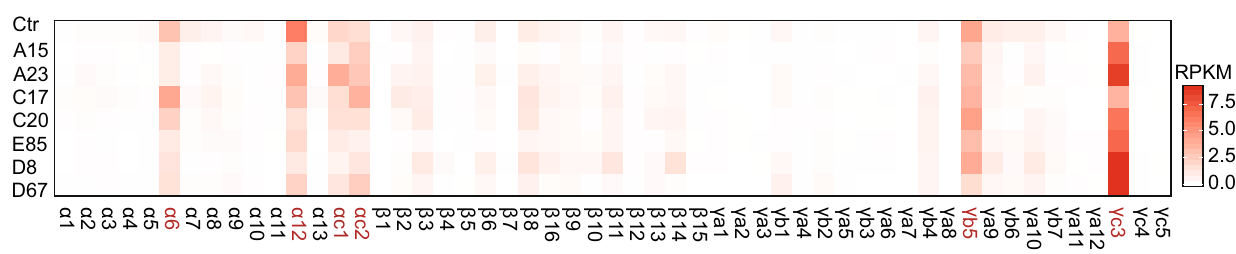
b Figure 1. Genetic dissection of the Pcdh α HS5-1 enhancer architecture by CRISPR DNA-fragment editing . (A) Schemat- ics of the three human Pcdh gene clusters (hPcdh α , β , and γ ) and the inversion experiments mediated by CRISPR DNA- fragment editing. The orientation of CBS arrays is indicated by horizontal arrowheads. The DNase I hypersensitive sites within super-enhancers are indicated by vertical arrows. The HS5-1 enhancer and its various CRISPR inversions are highlighted below. Two tandem CBSs in a reverse orientation ( HS5-1a and HS5-1b ) at the editing sites are also highlighted. SLC25A2 and TAF7 are two non-Pcdh genes. CBS, CTCF-binding site; HS, hypersensitive site; SE, super-enhancer; TF, transcription factor. (B) Shown are 4C chromatin-interaction pro fi les in the wild-type control (Ctr) and CRISPR cell lines with inversion of the CBS HS5-1b only (Inv I) or the HS5-1b combined with the middle region (Inv II) using the HS5-1 enhancer as a viewpoint. The signi fi cance of interactions ( P value) is shown under the read ’ s density. The log2 ratios between each inversion cell clone and wild-type cells are also indicated. (C) Shown are 4C chromatin-interaction pro fi les in wild-type control and CRISPR cell lines with inversion of the CBS HS5-1a only (Inv III) or the HS5-1a combined with the middle region (Inv IV) using the HS5-1 enhancer as a viewpoint. (D) Heatmap shows the alteration of expression patterns of members of the three Pcdh gene clusters resulting from CRISPR inversion of different enhancer and insulator (CBS) elements by RNA-seq